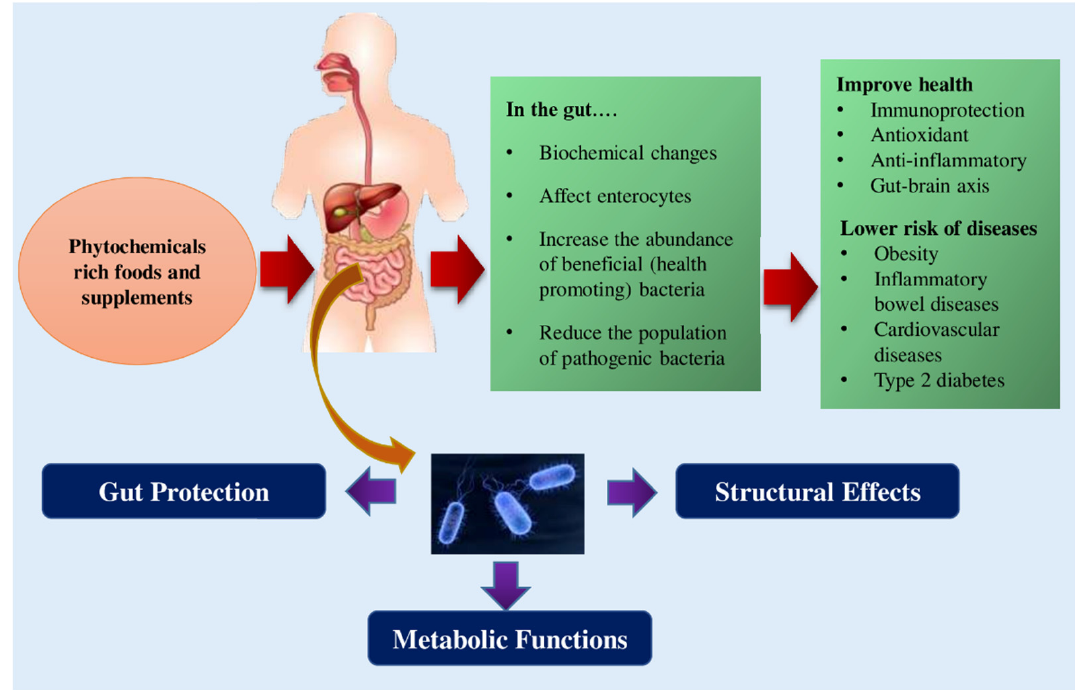
Figure 2. The influence of phytochemicals on GM and key roles of GM in humans (Self ‐ generated).